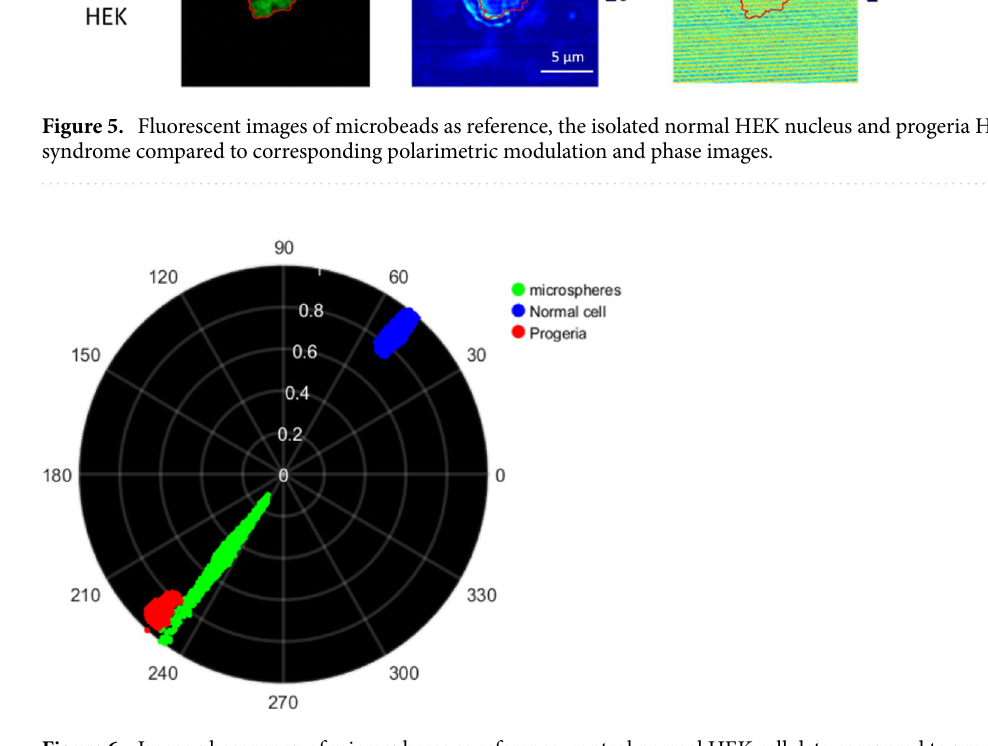
Figure 6. Image phasor map of microspheres as reference, control normal HEK cell data compared to progeria HEK cell syndrome discriminated by green, blue and red